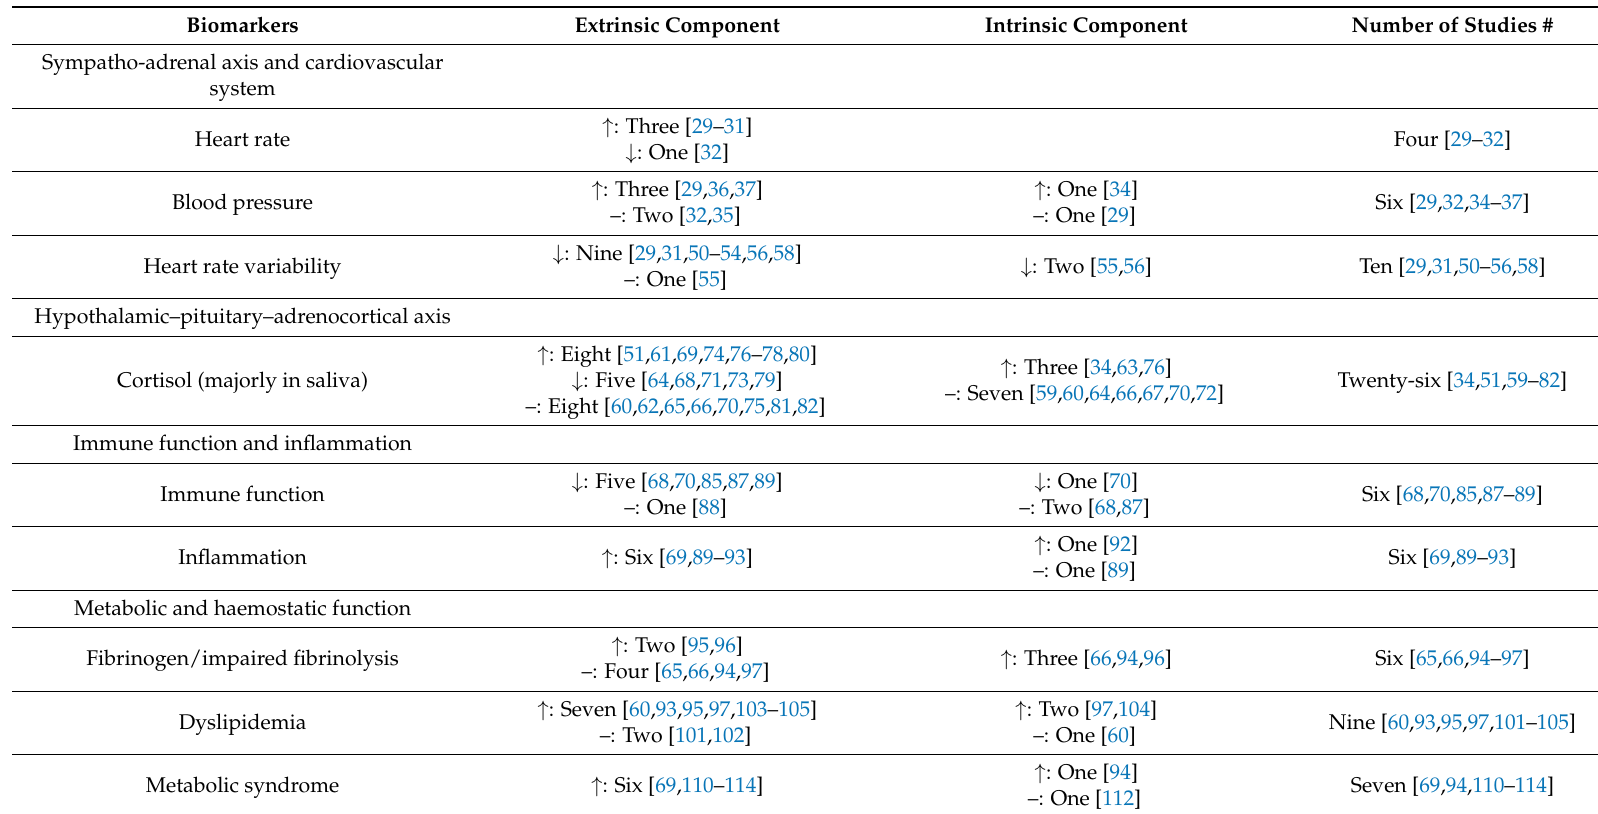
Table 1. Summary of effort–reward imbalance model and